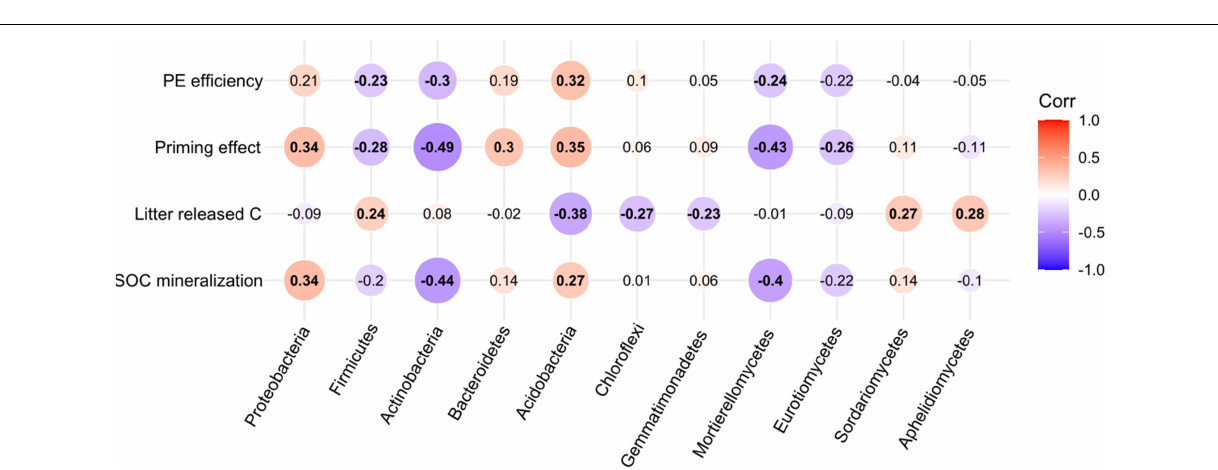
Frontiers in Microbiology |